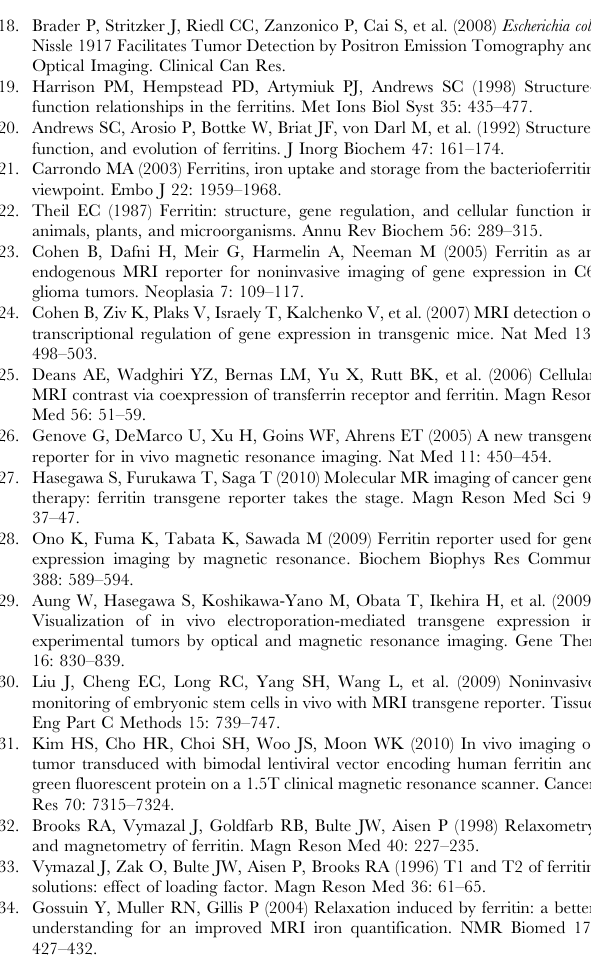
Figure S2 Three-dimensional reconstruction of the Ec N P BAD - bfr colonized tumor from Fig. 3 before and 24 h after L-arabinose injection. The surface of the tumor is transparent while dark voxels appear yellow (before L-arabinose injection) or red (after L-arabinose). The upper images show the 3D-reconstrcution of the tumor together with the plane that is shown in Fig. 3A. In the middle the same 3D-reconstruction is shown without the pictures from Fig. 3A. The lower images show the same tumor but from another angle. Table S1 Primer sequences used in this